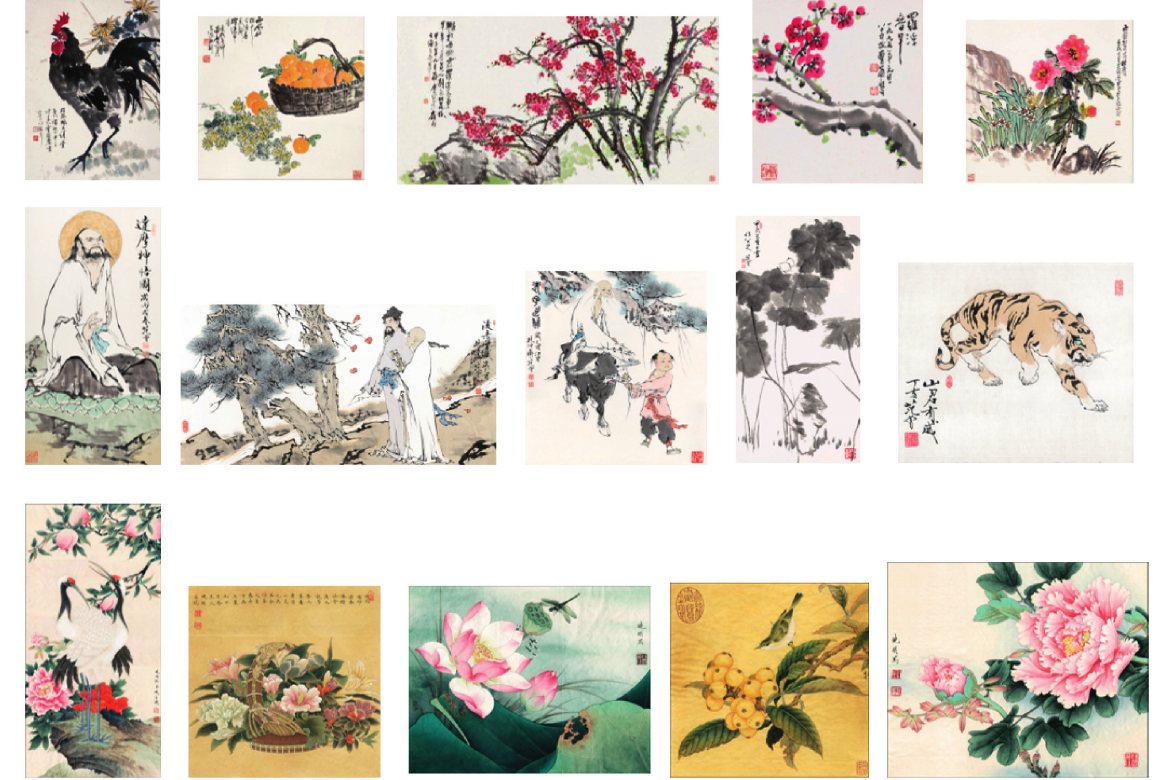
Figure 3: Some samples of the dataset in the experiment. The three rows show some samples of Cao Jianlou’s, Fan Zeng’s, and Li Xiaoming’s paintings, respectively. Table 2: Comparison of classification results of different classifiers on the Case-1 category of the dataset.